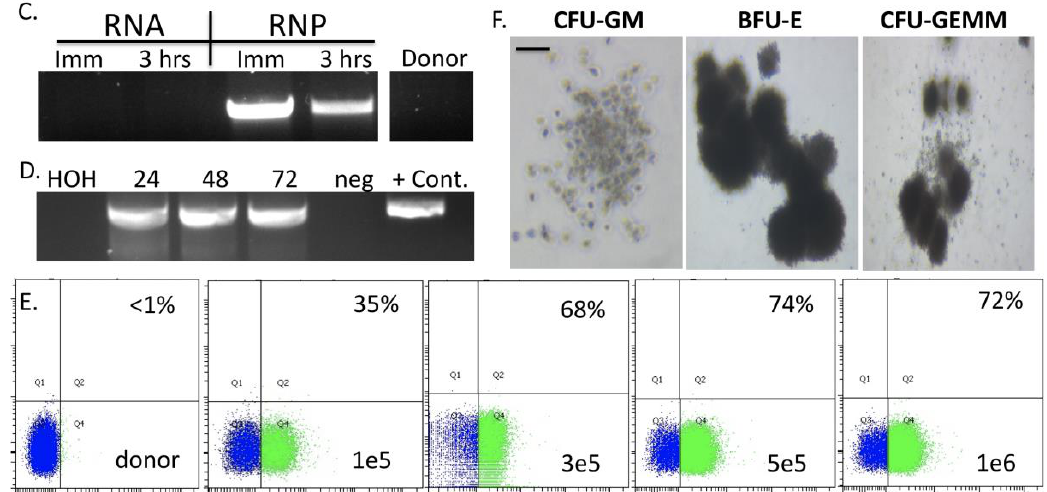
Figure 2. Genome editing optimization in human hematopoietic stem and progenitor cells. ( A ) Hematopoietic stem cell phenotyping. CD34 cells were isolated from cord blood and analyzed for CD34 and CD133, markers of hematopoietic lineage stem cells; ( B ) Gene editing experimental schema. Cas9 was delivered, via electroporation, to human cord blood derived CD34 + cells as mRNA with a guide RNA with phosphorothioate modifications or as a recombinant peptide with a gRNA without modification. Adeno-associated virus (AAV) serotype 6 was used to deliver a homology directed repair template for the PPP1R12C gene on chromosome 19. The homologous recombination repair reporter is shown in relation to the PPP1R12C target locus. The donor contains donor arms to the PPP1R12C locus that flank a splice acceptor (SA), 2A sequence, green fluorescent protein gene (GFP), and the bovine growth hormone polyadenylation signal (pA). Insertion into the first intron results in splicing into the reporter with subsequent GFP expression. Green boxes represent exons. ( C ) Molecular readout for homologous recombination. AAV-6 donor was added to cells that were electroporated with Cas9 mRNA or protein immediately after gene transfer (imm) or 3 h post electroporation. HDR analysis was done at 72 h using an “inside-out” PCR with one primer inside the donor and the second located at the endogenous locus (arrows in ( B )). ( D ) Homology directed repair temporal kinetics. Cas9 RNP was electroporated into CD34 cord blood cells and AAV-6 donor (multiplicity of infection (MOI) 5e5 GC/mL) was added immediately after gene transfer. Cells were screened for HDR by allele specific inside/out PCR at 1, 2, or 3 days after donor delivery. ( E ) HDR donor template dose optimization. Various donor concentrations were added as AAV-6 particles at the indicated multiplicity of infection (lower right quadrant of FACS plot). At 72 h post modification flow cytometry was performed to assess GFP expression from the donor. Percentage of GFP positive cells are shown in each box. ( F ) Representative images of MethoCult colony forming unit assay. CFU-GM = granulocyte/macrophage, BFU-E = burst forming unit-erythroid CFU-GEMM = granulocyte, erythrocyte, monocyte, megakaryocyte. All data are representative of at least three experiments. HOH = water; neg = negative control, untreated cells; +Cont = K562 cells that were generated for use as a positive control. Black bar is 100 microns and photomicrographs were taken at 400× magnification.